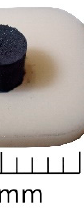
Figure 1. Structure of the sample on the white sample plate made of Al 2 O 3 before the trial.